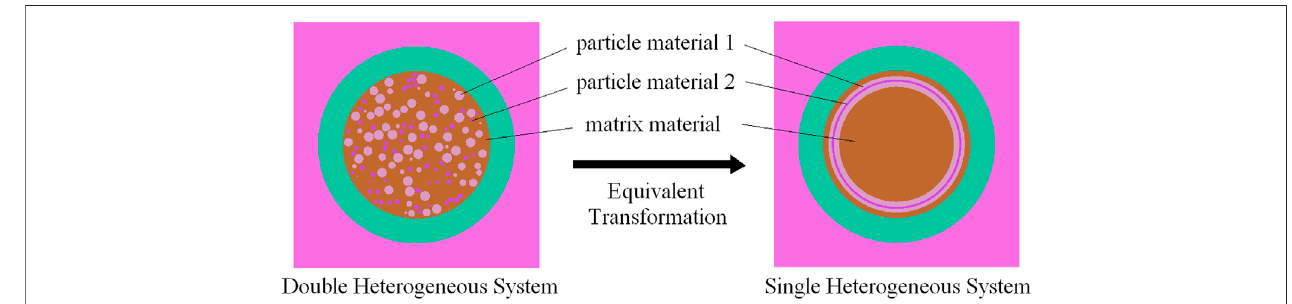
FIGURE 5 | Schematic diagram of the TRRPT method.